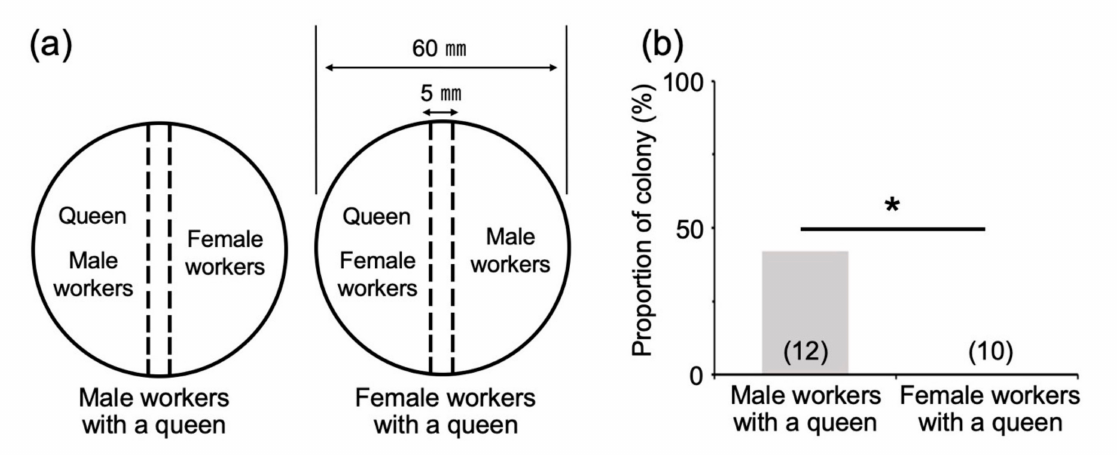
Figure 6. Effects of queen separation on male reproductive soldier development. ( a ) Incipient colonies two months after the emergence of the first soldier were prepared for the analysis. Broken lines indicate metal-wire mesh. ( b ) Male reproductive soldier development was only observed in the male-workers-with-queen treatment. The numbers of colonies examined are indicated in parentheses. Asterisk denotes significant differences (Fisher’s exact test, * p <